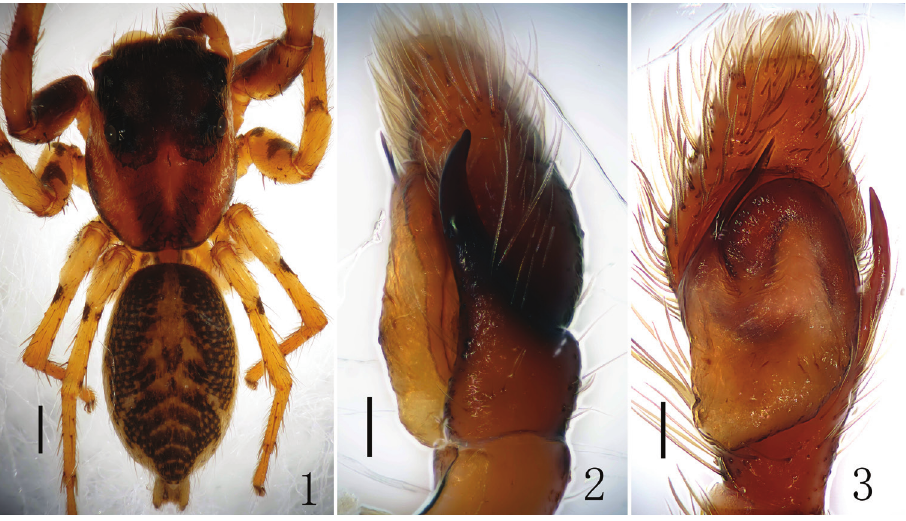
Figures 1–3. Yaginumaella lushuiensis sp. n. 1 male body, dorsal view 2 male palp, retrolateral view 3 male palp, ventral view. Scale bars: ( 1 ) 0.5 mm; ( 2, 3 ) 0.1 mm.